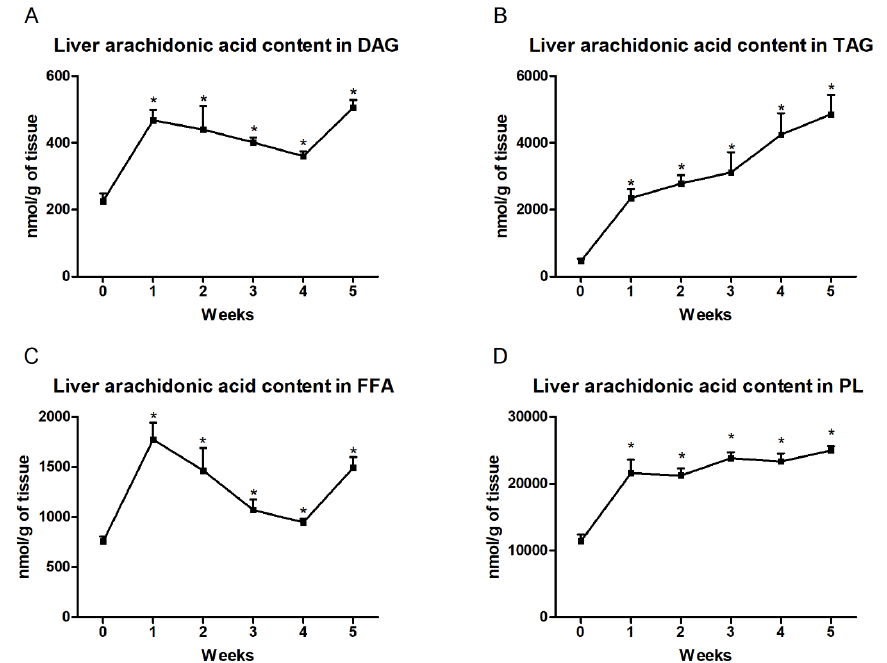
Figure 2. Liver contents of arachidonic acid in the ( A ) diacylglycerol (DAG), ( B ) triacylglycerol (TAG), ( C ) free fatty acid (FFA) and ( D ) phospholipid (PL) fractions. Changes in the arachidonic acid content in the selected lipid fractions were examined by the gas–liquid chromatography (GLC) method. The data are expressed as mean ± SD and are based on six independent determinations. * p < 0.05, significant difference compared with the control group (0 week).